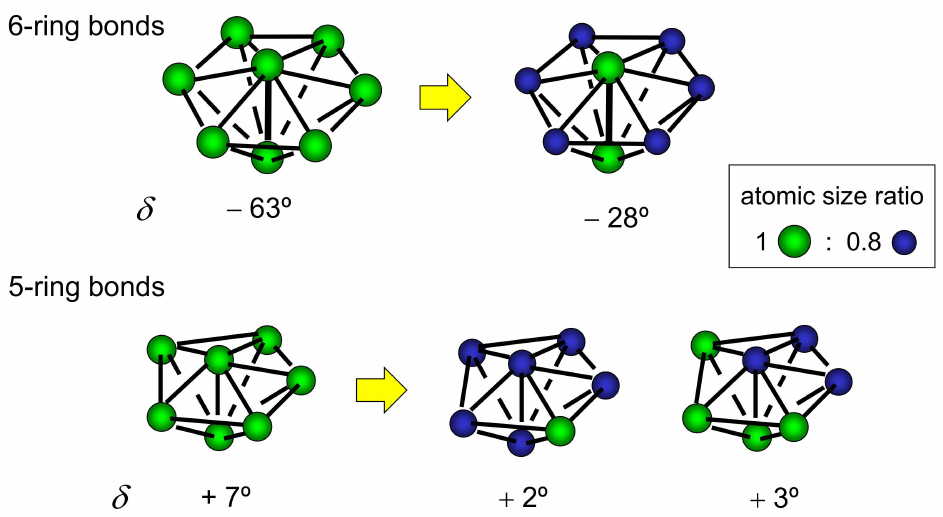
Figure 13. Decrease in the deficit angles by introducing the atomic size difference of 0.2 for the 6-ring bonds ( top ) and the 5-ring bonds ( bottom ).